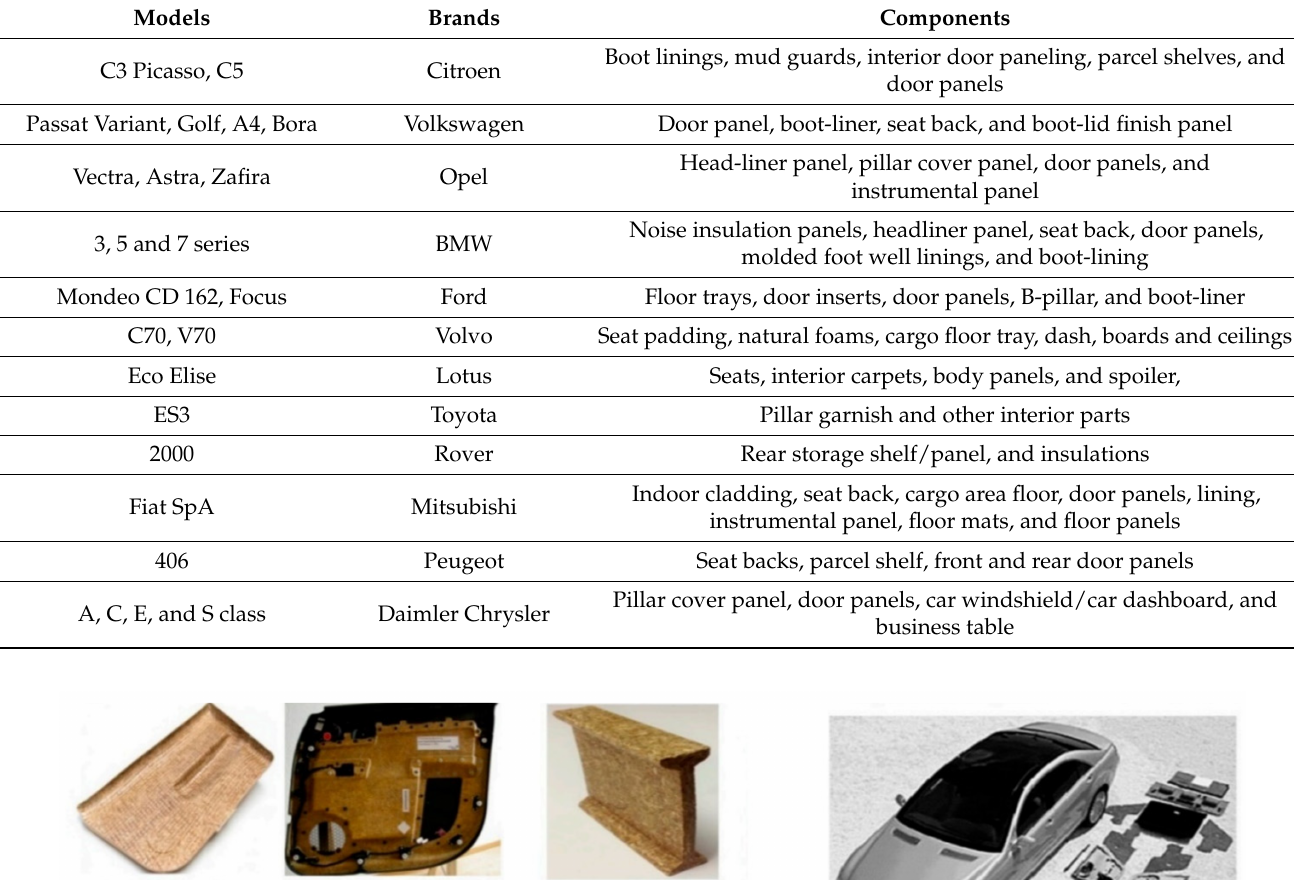
Table 8. Automotive models and their components implementing natural fiber composites.